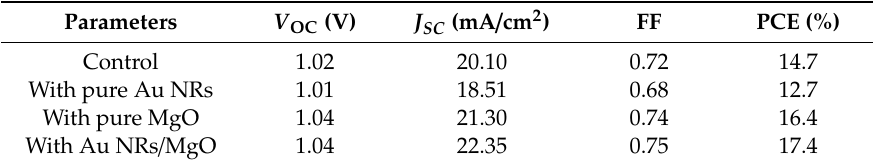
Figure 1. ( a ) J–V curves of perovskite solar cell (PSC) devices based on porous TiO 2 without and with Au NRs and MgO coating. ( b ) FESEM image of as-deposited gold NRs. ( c ) Absorbance spectrum of Au NRs and Au spheres (about 20 nm in diameter) suspensions. ( d ) FESEM image of the top surface morphology of the porous TiO 2 layer modified with Au NRs. Table 1. Photovoltaic parameters of the PSCs based on m-TiO 2 with and without Au nanorods (NRs) and / or